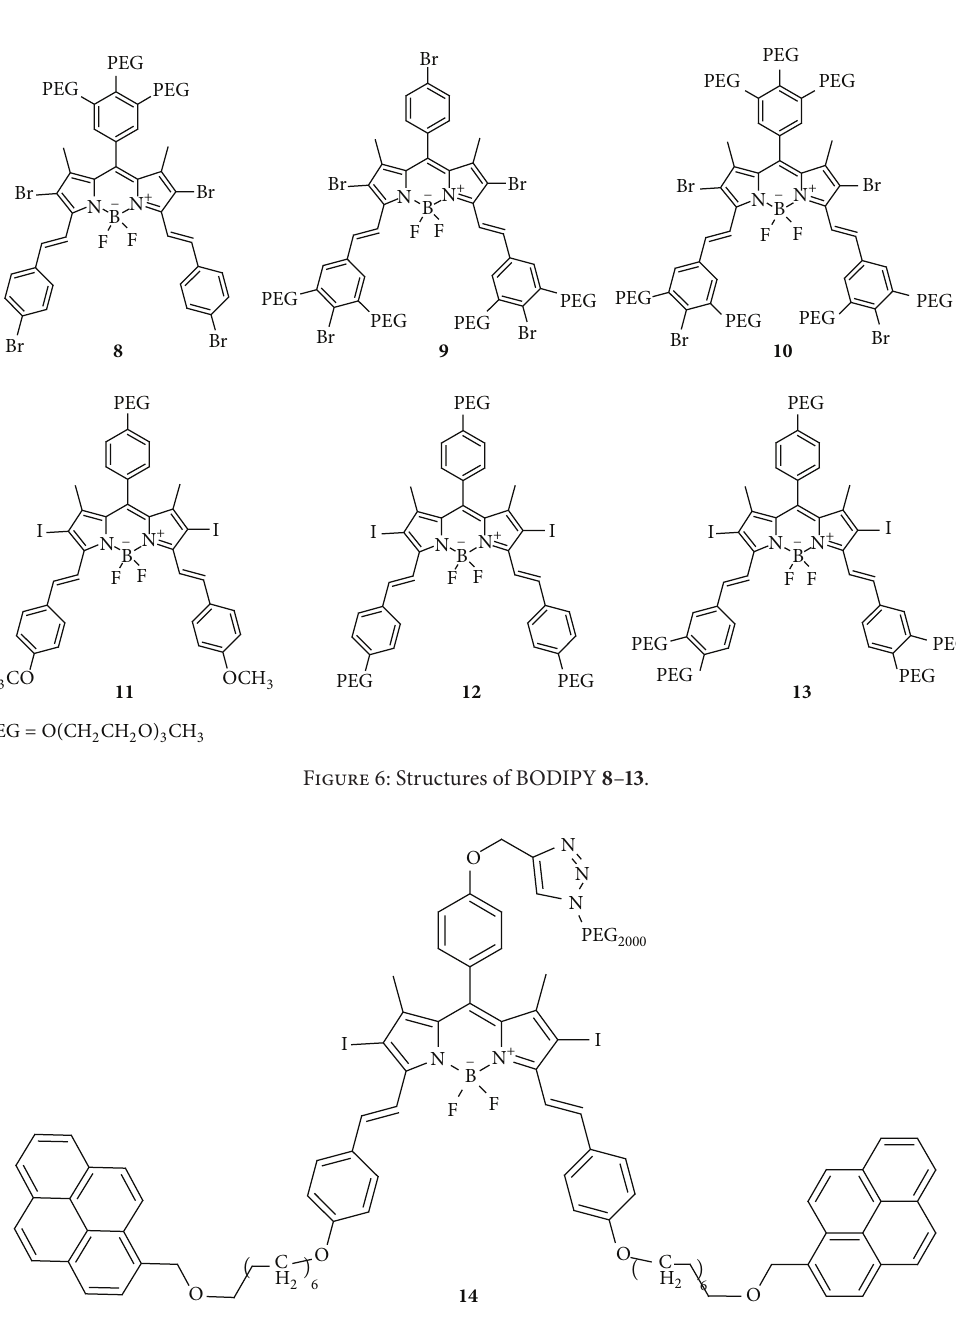
Figure 7: Structure of BODIPY 14 with delivery